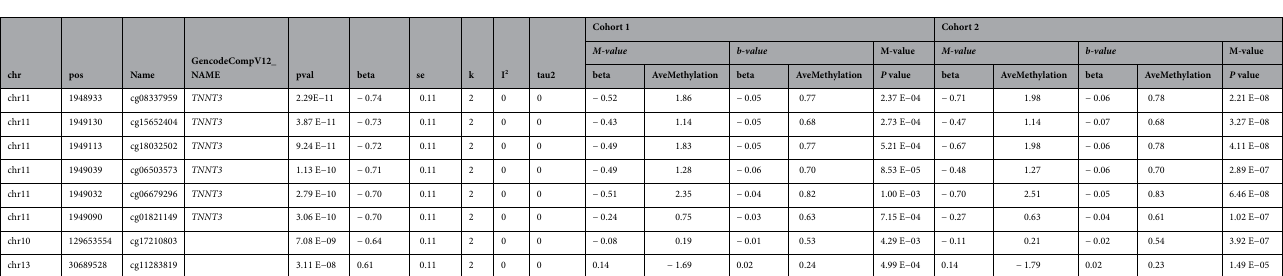
Table 1. MDD EWAS meta-analysis genome wide significant CpG sites. beta, estimated coefficients of the model; k, number of studies included in the analysis; pval, corresponding p values; tau2, estimated amount of (residual) heterogeneity; I 2 statistics, estimates (in percent) how much of the total variability in the observed effect sizes (which is composed of heterogeneity plus sampling variability) can be attributed to heterogeneity among the true